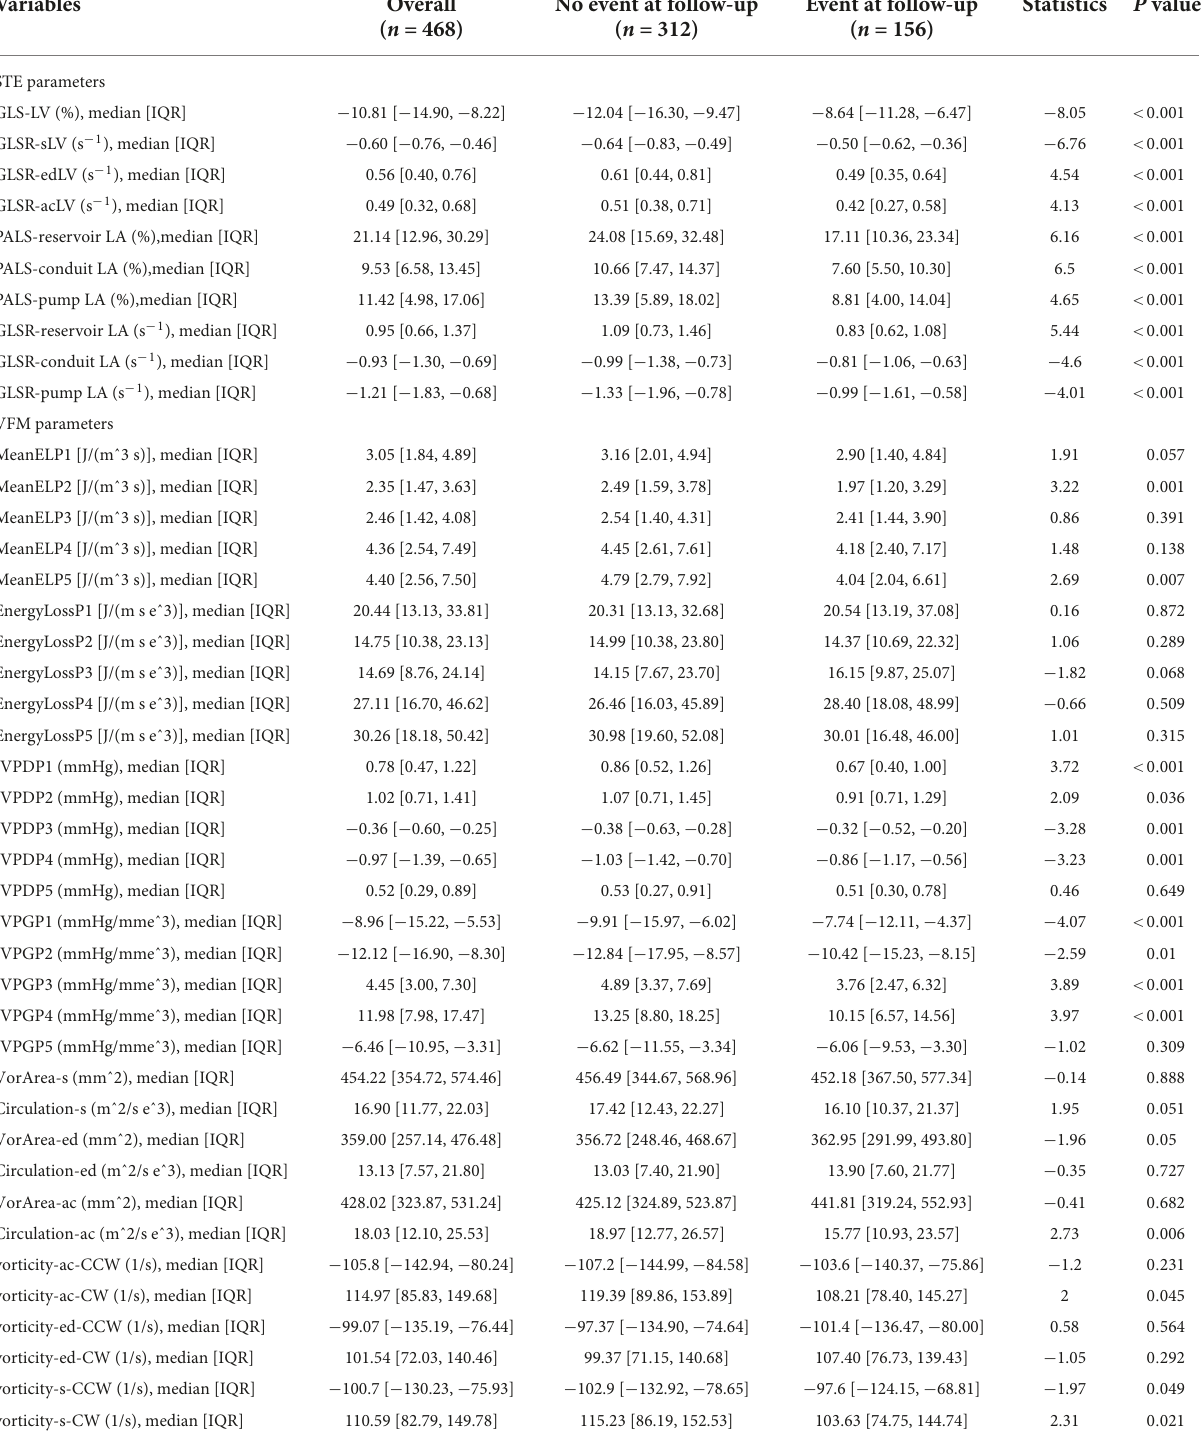
TABLE 3 Echocardiographic characteristics of speckle tracking echocardiography (STE) parameters and vector flow mapping (VFM) parameters divided by major cardiovascular events (MACE). Variables Overall